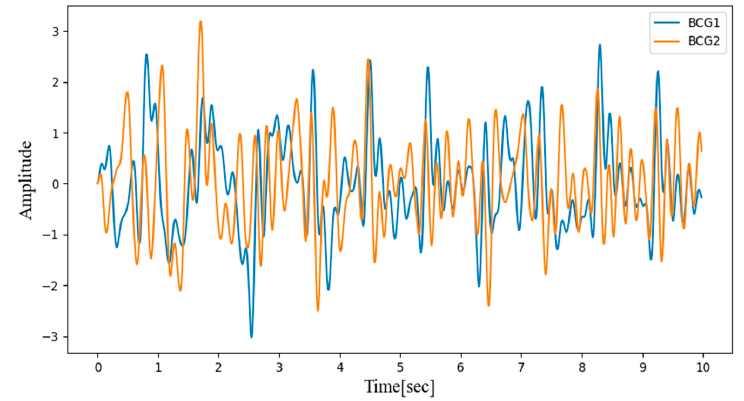
Figure 2. Two-channel BCG signals measured in the back and bottom seat applied to the Butterworth band-pass filter.